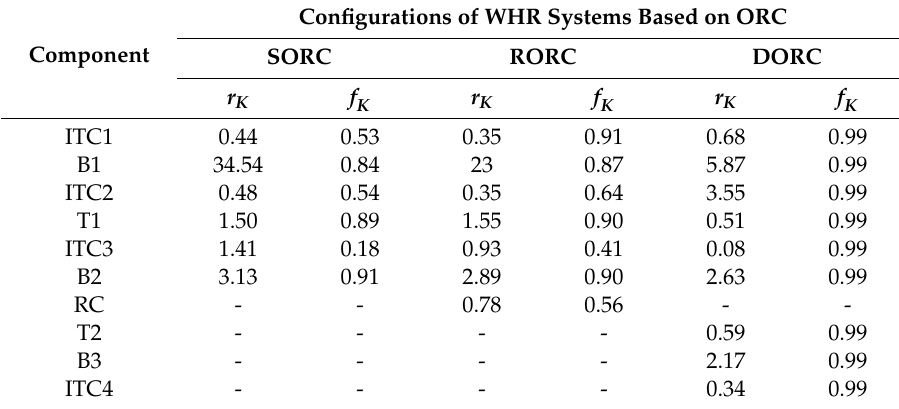
Table 7. Relative cost di ff erence and exergoeconomic factor by a system component.